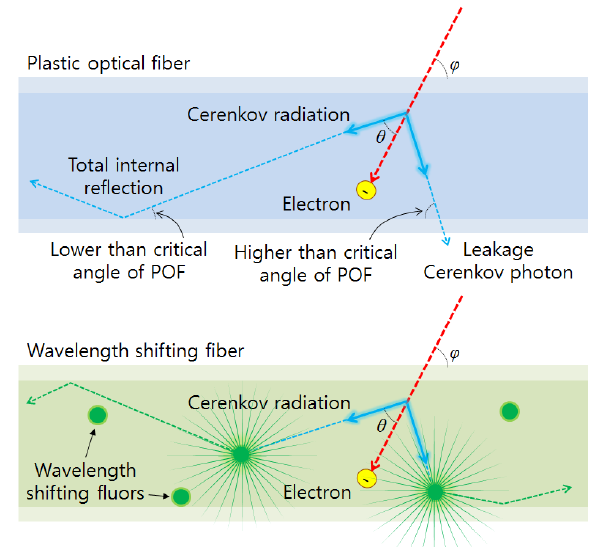
Figure 9. Transmission of light signals generated in a POF and a WSF.